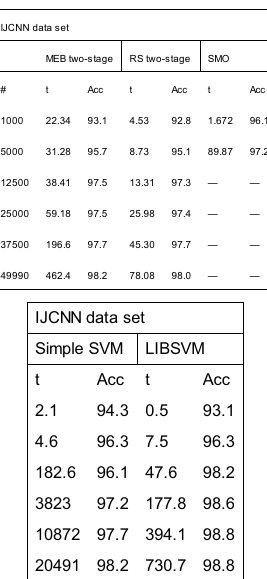
Table 2. Training time and accuracy of different algorithms on IJCNN 2001 data set